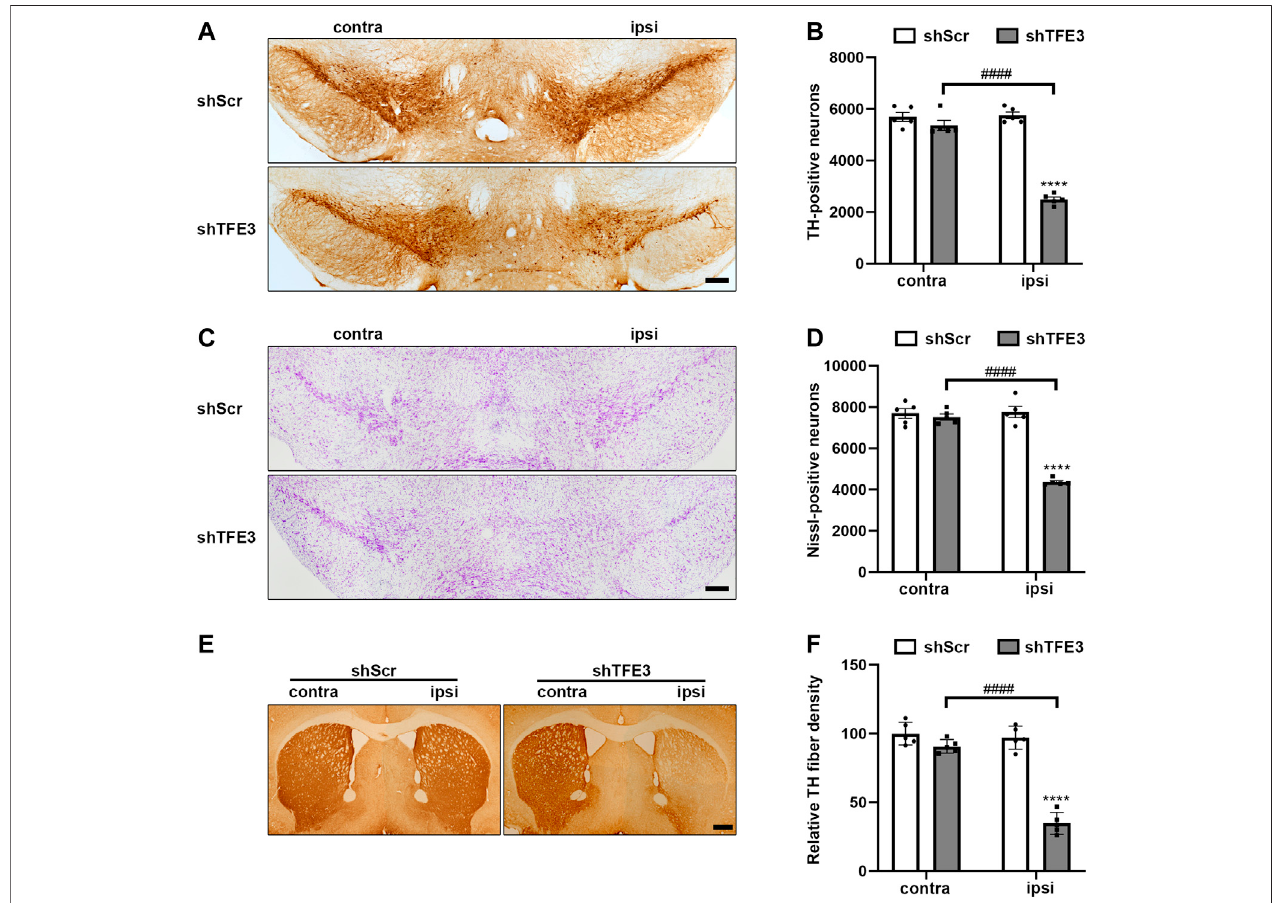
FIGURE 3 | TFE3knockdowninducesdegenerationofdopaminergicneurons. (A,C) ImmunohistochemicalTHstaining (A) andNisslstaining (C) ofmidbrainsections in mice after AAV-shScr or AAV-shTFE3 injection. Scale bars: A, C 200 μ m. (B, D) Stereological cell counts of TH-positive (B) and Nissl-positive (D) neurons in the SN. (E) ImmunohistochemicalTHstainingofstriatalsectionsinmiceafterAAV-shScrorAAV-shTFE3injection.Scalebars:500 μ m. (F) Quantitationofopticaldensitiesofthestriatal THimmunostaining;n (cid:1) 5pergroup.Dataareexpressedasthemean ± SEM.**** p < 0.0001,#### p < 0.0001,ANOVAfollowedbyTukey ’ smultiplecomparisonstest.